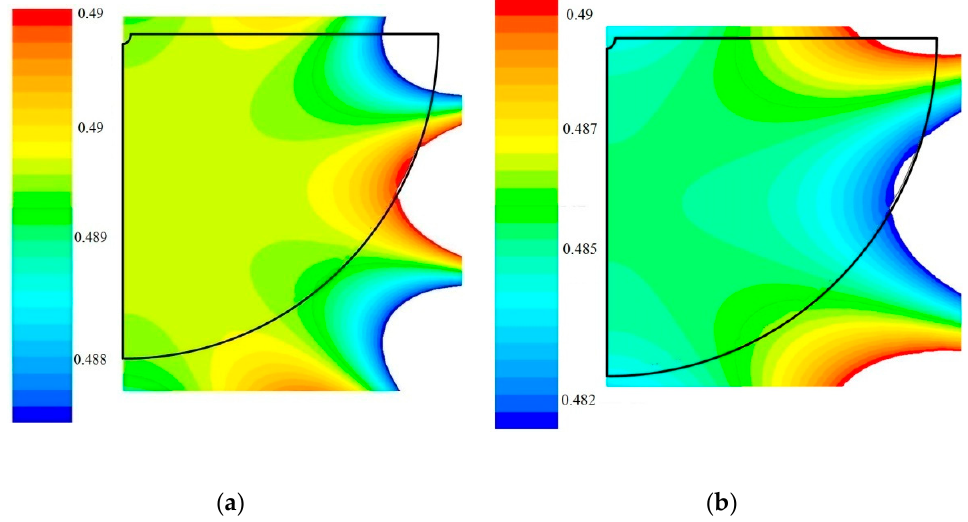
Figure 3. Distribution of the magnetic field of ( a ) Maxwell coil; and ( b ) Helmholtz coil.